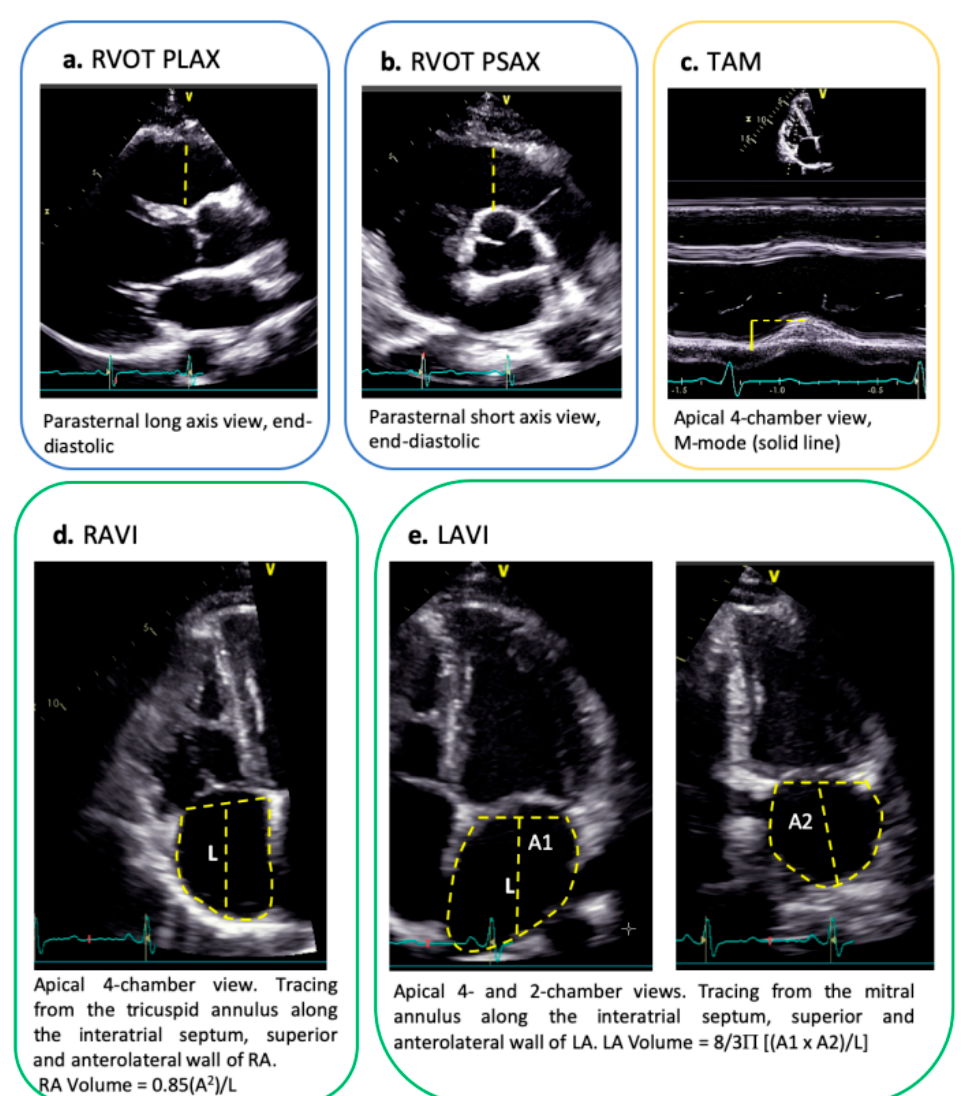
Figure 1. Echocardiographic measurements [11]. ( a ). RVOT measurement in parasternal long-axis view; ( b ). RVOT measurement in parasternal short-axis view; ( c ). TAM measurement from M-mode of four-chamber apical view; ( d ). apical four-chamber view with focus on the right side and 2D volumetric measurement of RAVI according to the area-length method; ( e ). apical four- (left) and two-chamber view with focus on the left atrium to measure the LAVI according to the area-length approximation. A1: atrial area in 4 chamber view, A2: atrial area in 2 chamber view. LAVI, left atrial volume indexed for body surface area; RAVI, right atrial volume indexed for body surface area; RVOT, right ventricular outflow tract; RV, right ventricle; TAM, tricuspidal annular motion.